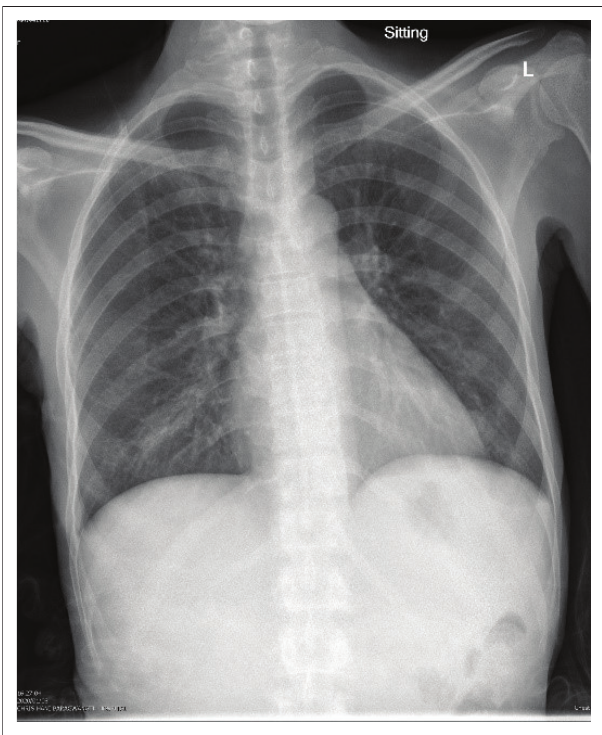
FIGURE 1: Chest radiograph on patient on readmission (1-month post- antituberculosis treatment). Patchy consolidation of the right upper lobe, as well as the right and left lower lobes. Silhouetting of the right heart border. These are features in keeping with bronchopneumonia with right middle lobe consolidation and/or atelectasis.